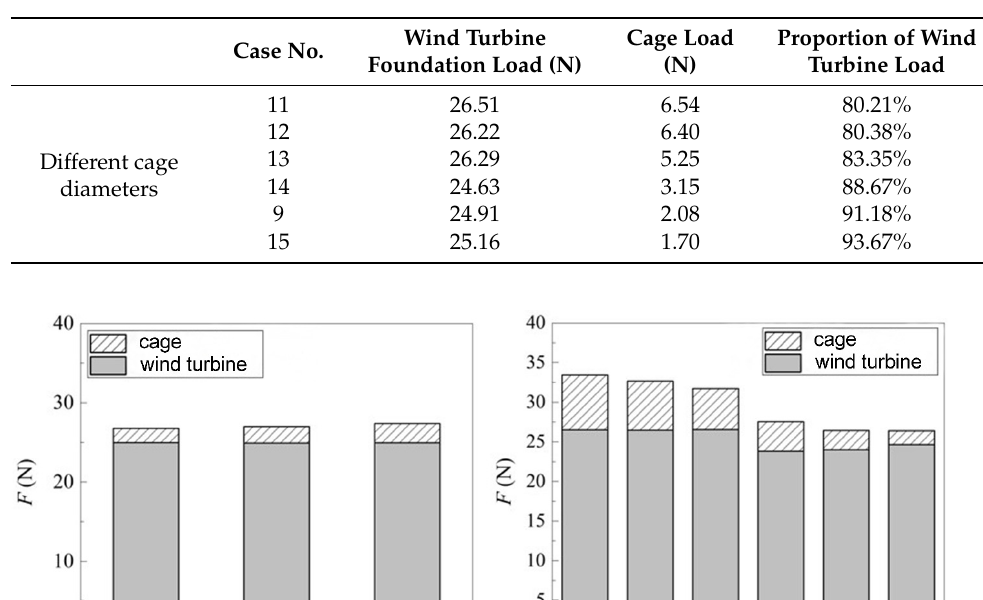
the cages. ( a ) Time domain curve. ( b ) Frequency domain diagram.